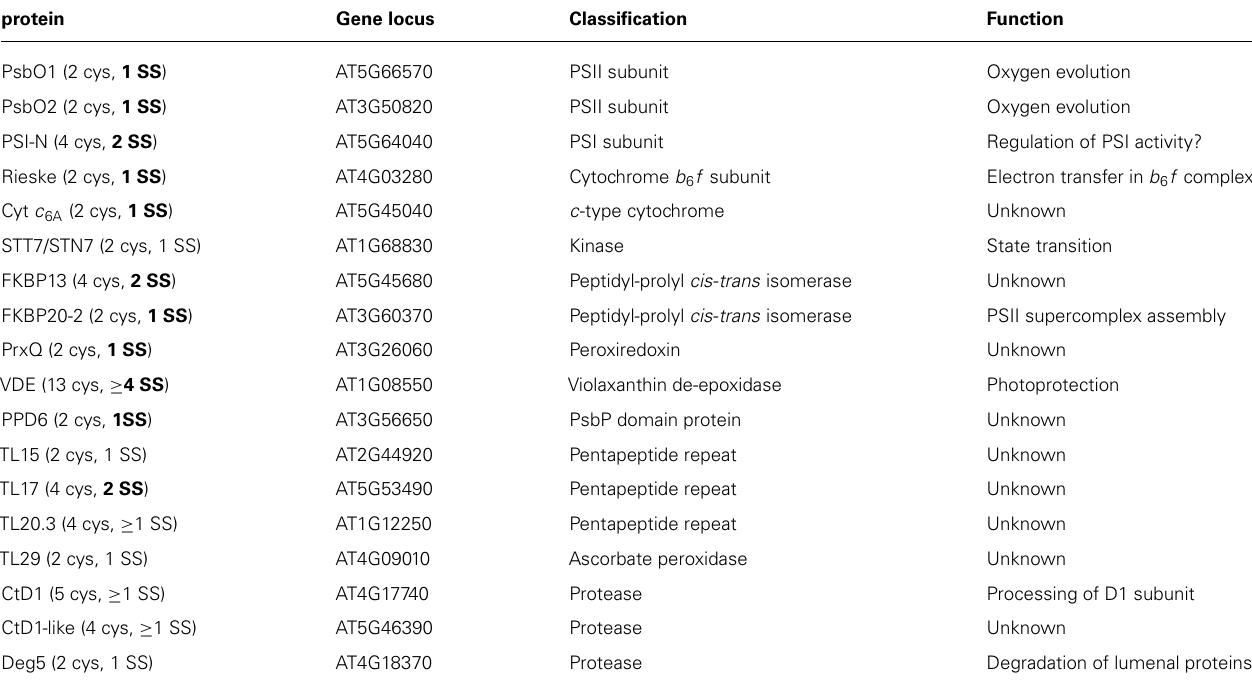
Table 1 | Lumenal disulfide bonded proteins in Arabidopsis